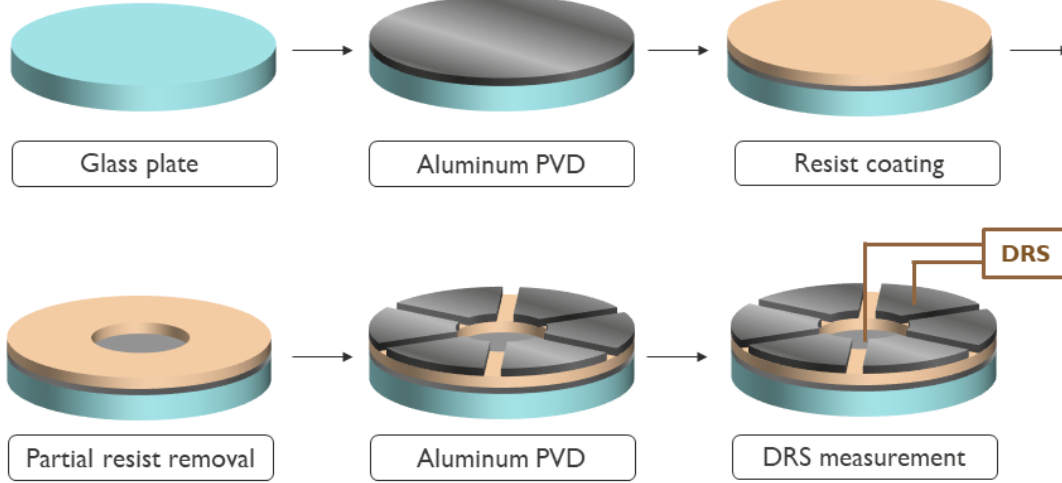
Figure 2. Schematic representation of a sample preparation for a dielectric response spectroscopy (DRS) measurement of a resist layer.